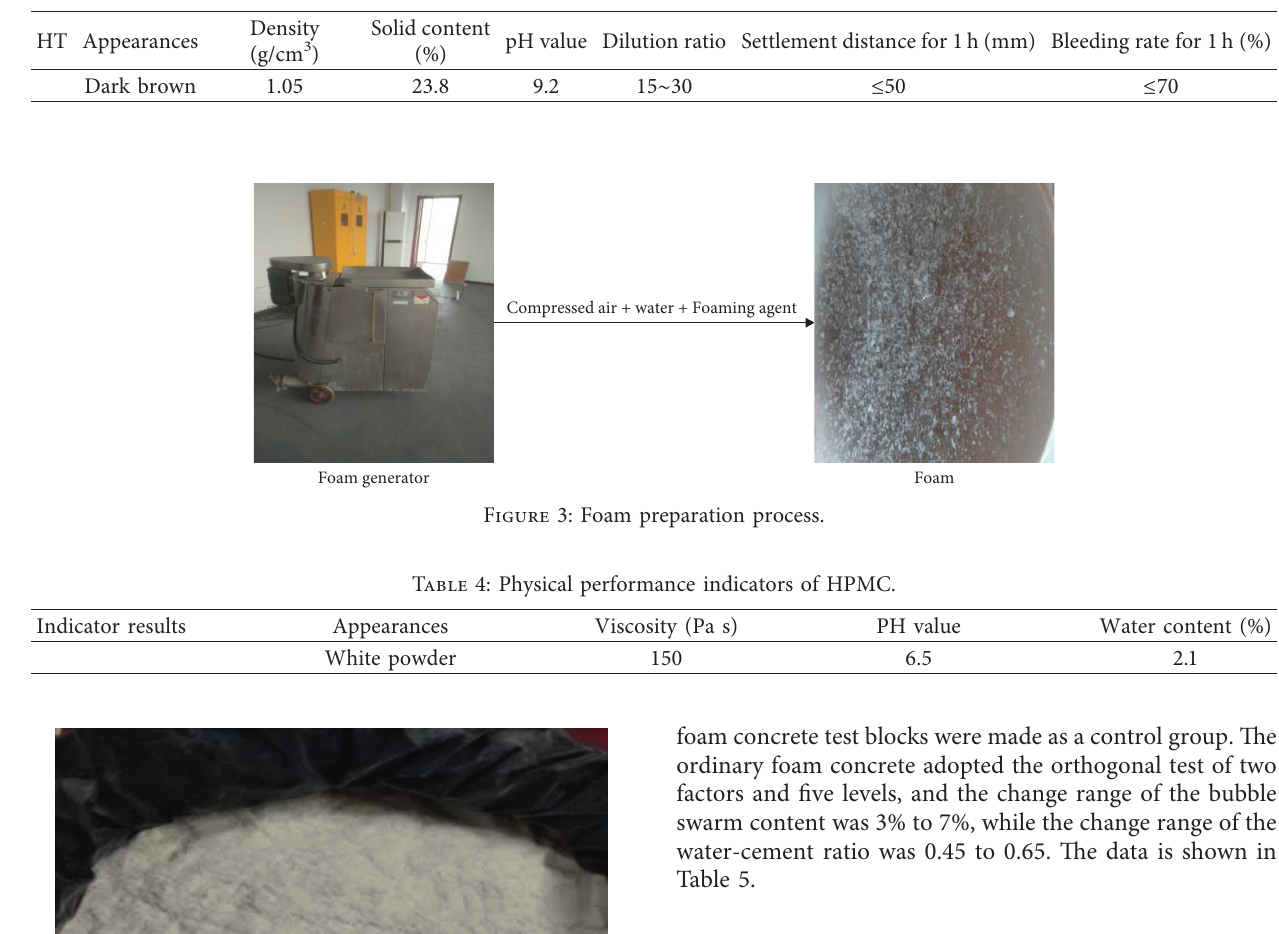
Table 3: Physical performance indicators of HT composite foaming agent.